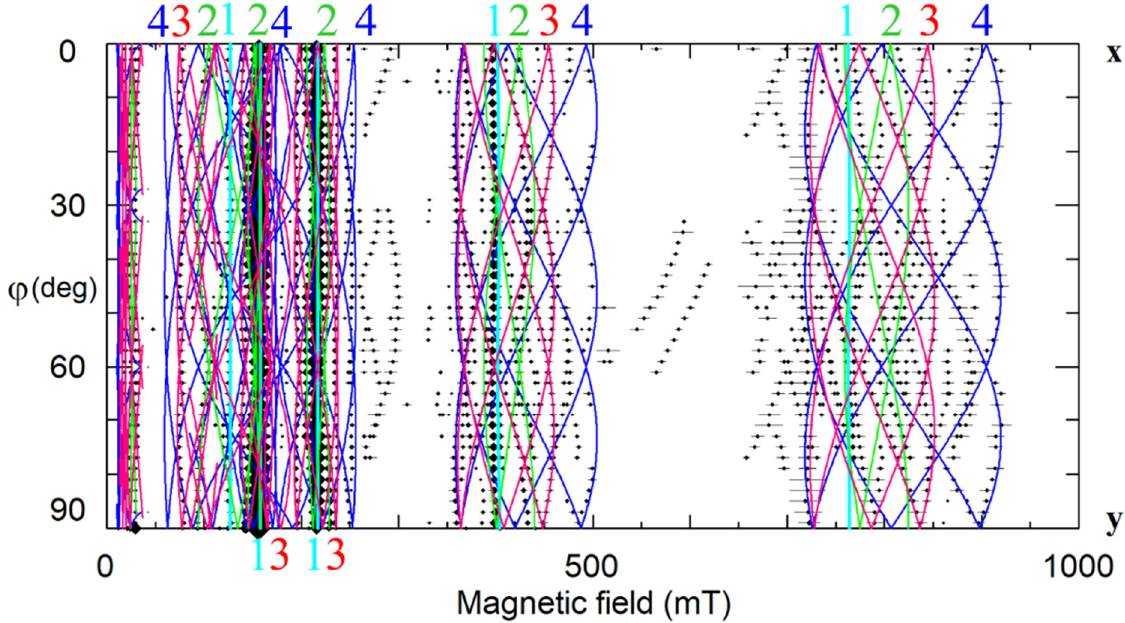
Figure 21. The angular dependencies of EPR spectra in xy plane for Li-rich LN:Gd 3+ , ν = 9.26 GHz. Rhombs represent line positions; horizontal whiskers—line widths. Cyan, lime, fuchsia, and blue curves are simulated dependencies for axial Gd 1 , and low-symmetry Gd 2 , Gd 3 , and Gd 4 centers, respectively.